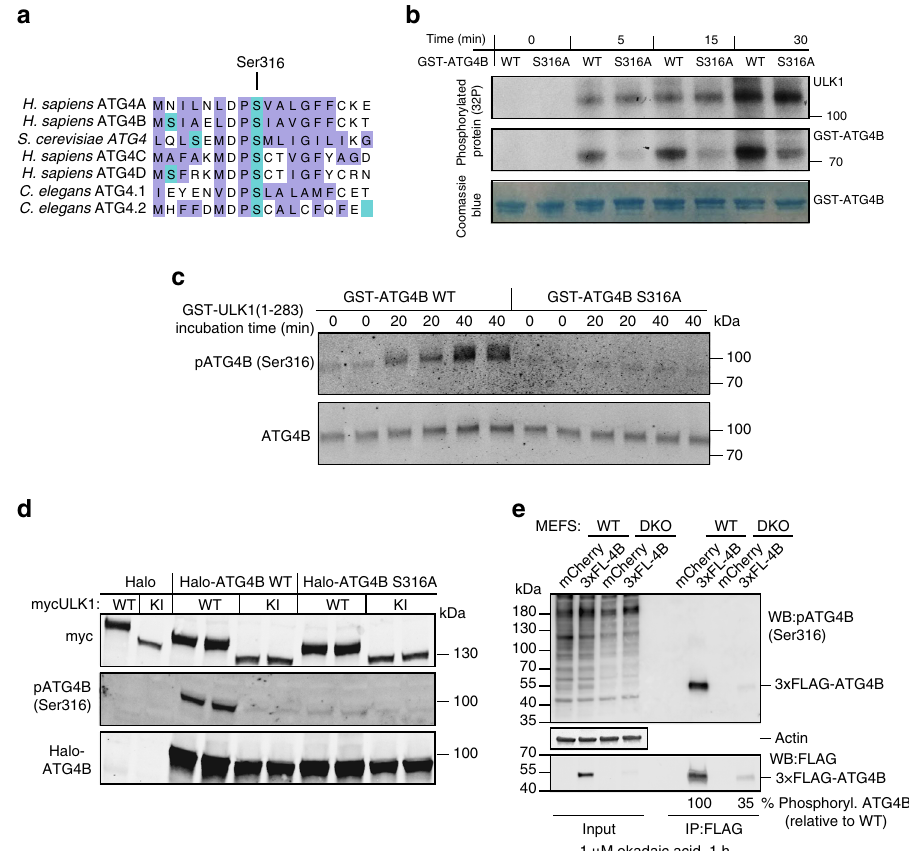
Fig. 2 ATG4B Ser316 is a target residue of ULK1 phosphorylation. a Clustal Omega multiple alignment of ATG4 protein sequences surrounding hATG4B serine 316 from different isoforms and species; highlighted in green are serine residues and in violet hydrophobic amino acids. b In vitro radioactive phosphorylation assay with WT or ATG4B S316A mutant at different time points after addition of recombinant active ULK1. Coomassie blue staining is shown as an ATG4B loading control. c GST-ATG4B or GST-ATG4B S316A mutant was incubated for the indicated times with GST-ULK1 (1 – 283); samples were then assayed with a custom phospho-speci fi c antibody against Ser316 of human ATG4B — pATG4B (Ser316) or total ATG4B. d Total lysates from wild-type (WT) or ULK1/2 double knockout (DKO) mouse embryonic fi broblasts (MEFs) transfected with 3×-FLAG-tagged ATG4B or mCherry as a control and treated with 1 µ M okadaic acid for 1 h were probed with the pATG4B(Ser316) antibody and with an anti-ACTIN antibody as loading control. In parallel, lysates from the same samples were subjected to immunoprecipitation with FLAG M2 af fi nity gel and probed for pATG4B(Ser316) and FLAG antibody. Phosphorylation level was calculated using densitometry, with pATG4B(Ser316) signal divided by FLAG signal for the same band, expressed as a percentage of the WT MEF IP sample. e HEK293T lysates from samples co-transfected with mouse WT myc-ULK1 or Kinase Inactive (KI) myc-ULK1 and the indicated Halo constructs for 24 h were blotted and probed with the indicated antibodies (one representative blot from three independent tested its activity in vitro towards the LC3B-GST construct. Compared with WT ATG4B, samples incubated with the phospho-mimetic mutant showed little free GST accumulation, again, almost as low as in the samples incubated with the catalytic dead ATG4B C74S mutant (Fig. 3d). To study whether LC3-PE de-lipidation activity was also affected by phosphorylation on Ser316 of ATG4B, we tested the ability of the phospho-mimetic S316D mutant to de-lipidate LC3-PE from membrane-enriched preparations. We separated cytoplasmic and membrane fractions of HEK293T cells treated with Torin1 (a potent mammalian target of rapamycin (mTOR) inhibitor) and ba fi lomycin A1 (a late-stage autophagy inhbitor) and incubated the samples with recombinant ATG4B WT, S316D and C74S mutants (Fig. 3e). The membrane fraction showed a large amount of lipidated LC3-II compared with the cytoplasmic fraction in treated cells, which was sensitive to de-lipidation by WT ATG4B. Interestingly, we found ATG4B S316D to be inactive against cleavage of lipidated LC3, similar to catalytic inactive ATG4B C74S (Fig. 3e), suggesting that the phospho-mimetic ATG4B S316D is inactive in processing of LC3-II.